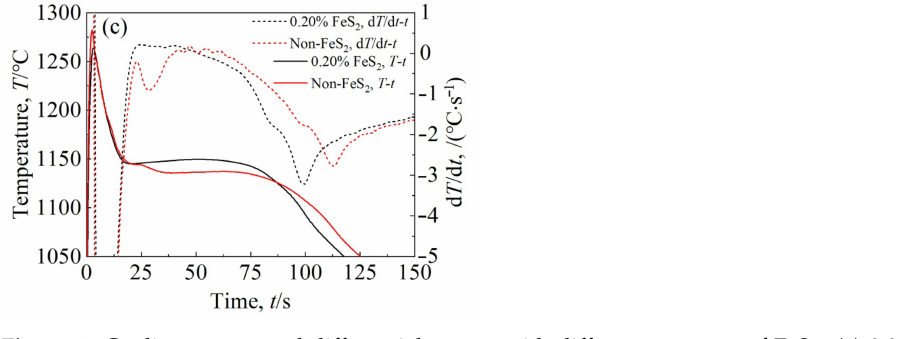
Figure 4. Cooling curves and differential curves with different amounts of FeS 2 : ( a ) 0.05% FeS 2 , ( b ) 0.10% FeS 2 , ( c ) 0.20% FeS 2 . Table 4. Key characteristic values of the curves when FeS 2 additive was added in one chamber of the sample cup.